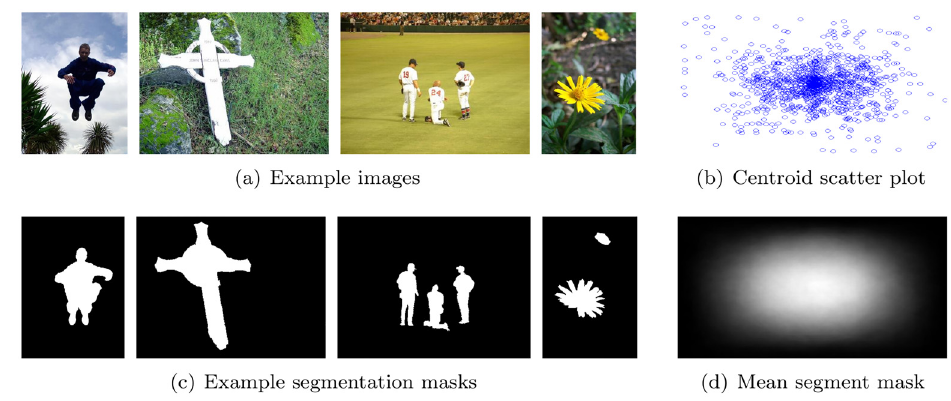
Fig 1. Illustration of the Achanta/Liu data set: example images (a), the corresponding segmentation masks (c), the mean over all segmentation masks (d), and the scatter plot of the centroid locations across all images